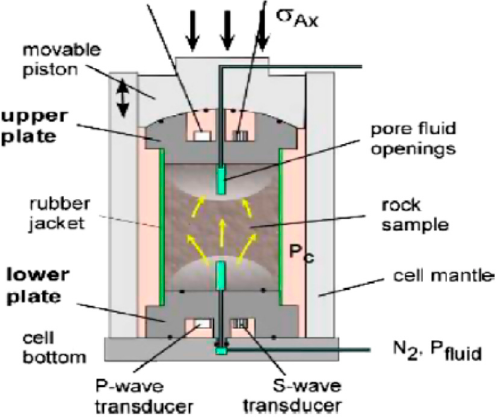
Figure 10. High-pressure triaxial cell used for the gas-injection tests [48].